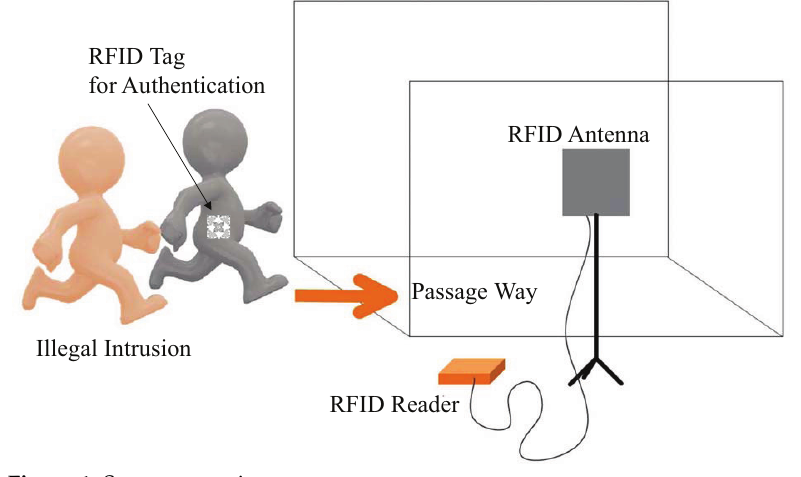
Figure 1. System